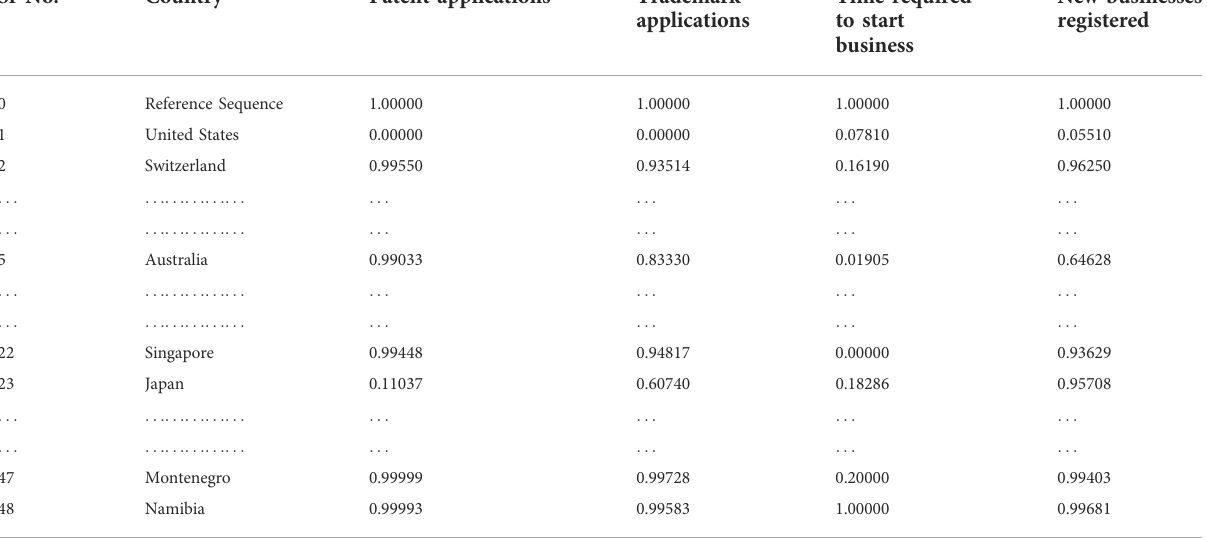
TABLE 5 Deviation sequences. Sr